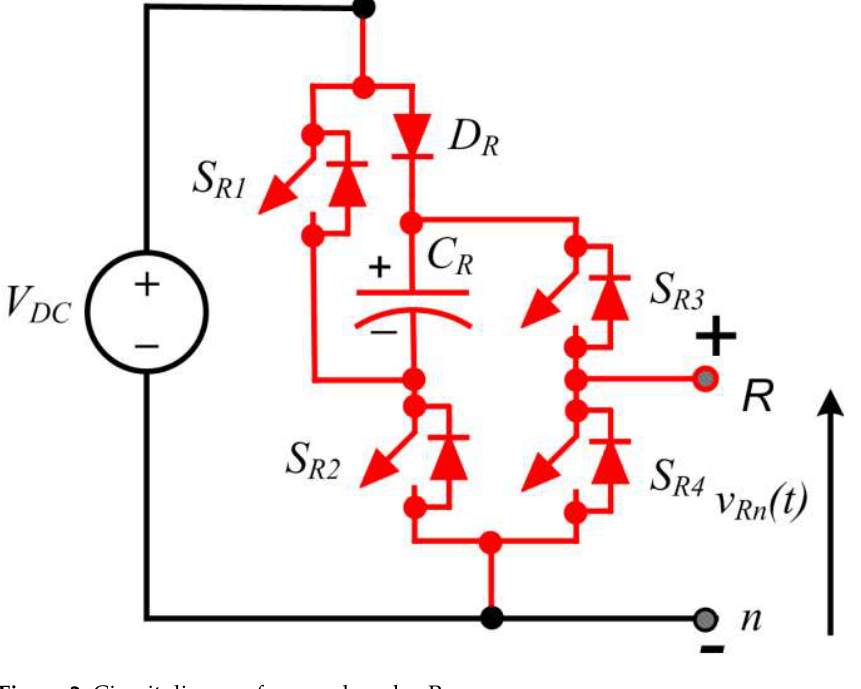
Table 1. Different switching modes and their corresponding positive pole voltages for phase leg “R”.